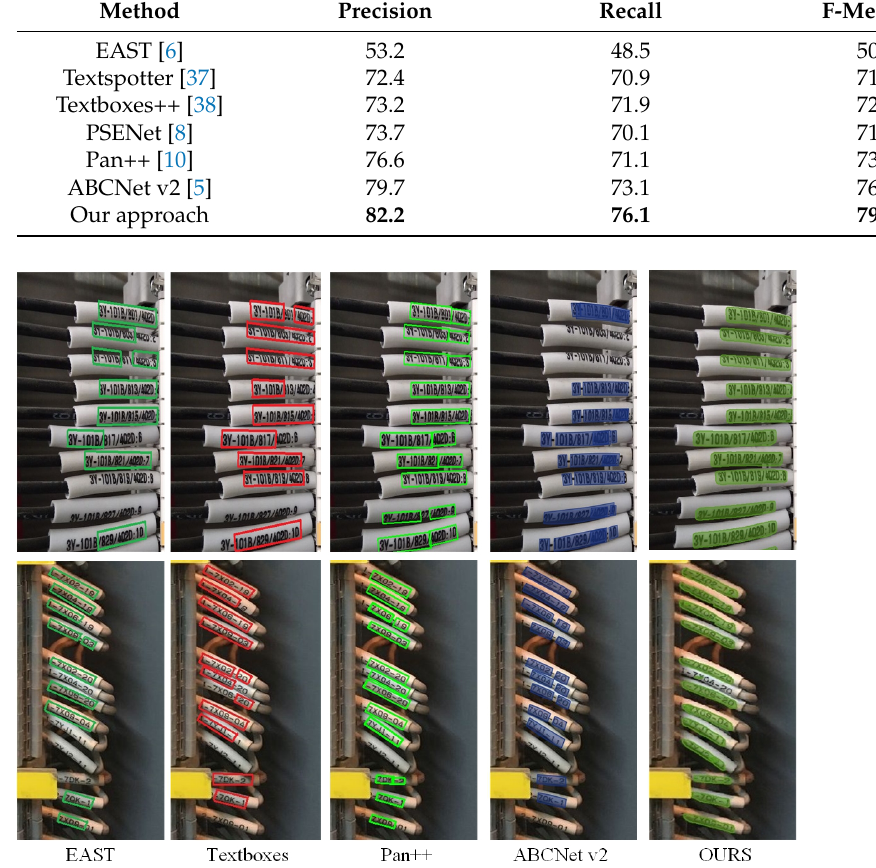
Figure 6. Qualitative comparisons of detection performance between state-of-the-art methods and the Rwin-FPN++. Compared with state-of-the-art methods, our Rwin-FPN++ network is more effective at detecting dense scene texts with various bends, occlusion, and lighting.